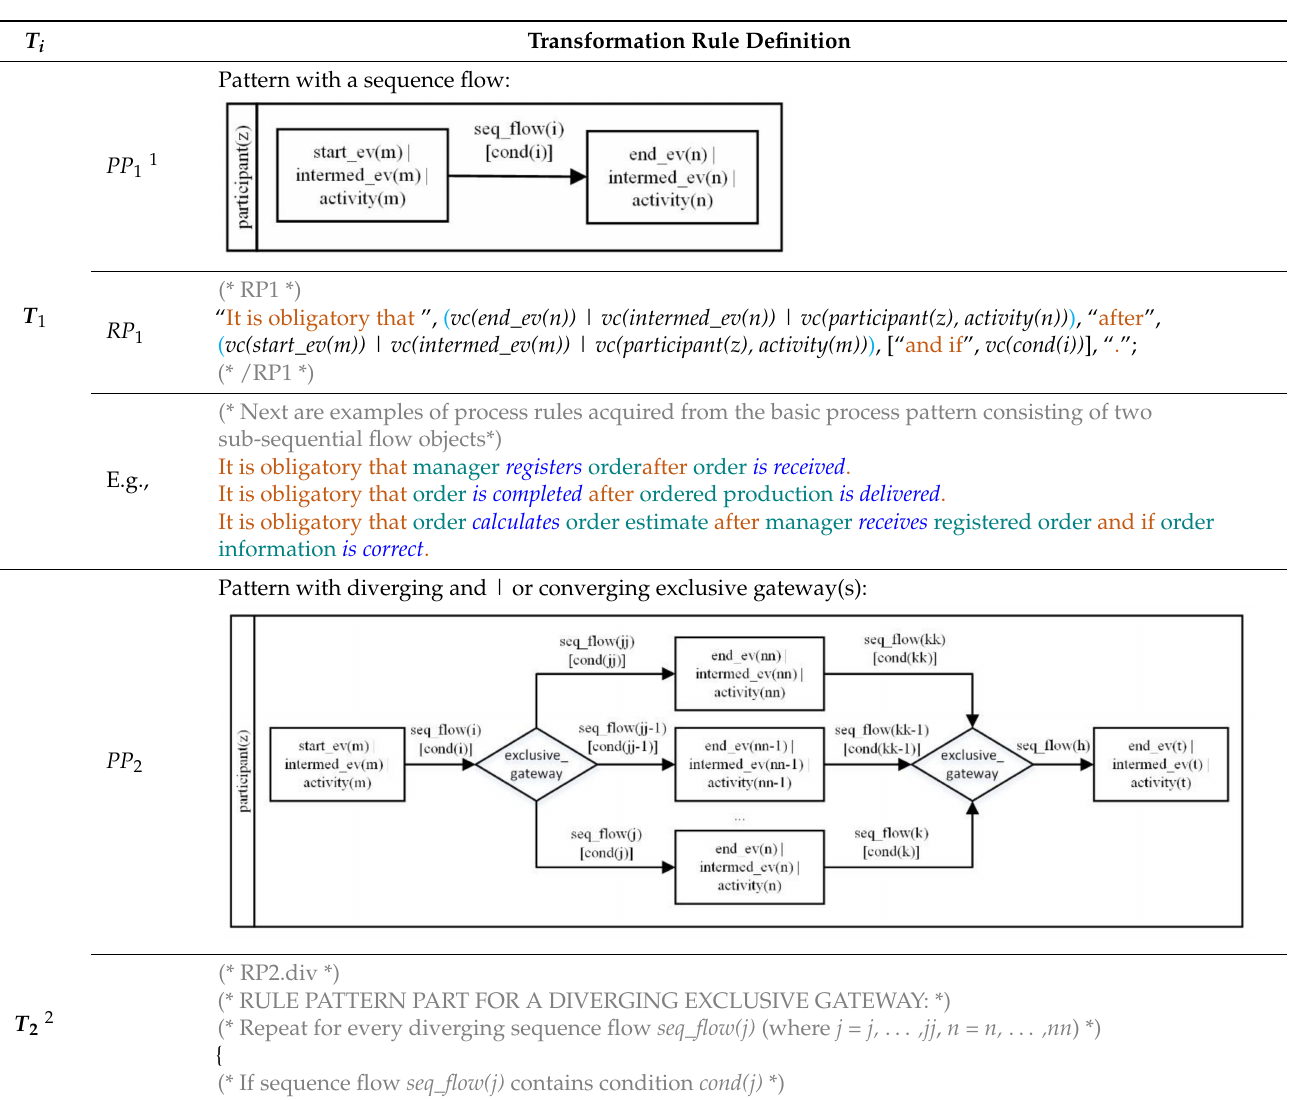
Table 1. Rules for the transformation of BPMN processes to SBVR process rules ( T i : PP i → RP i